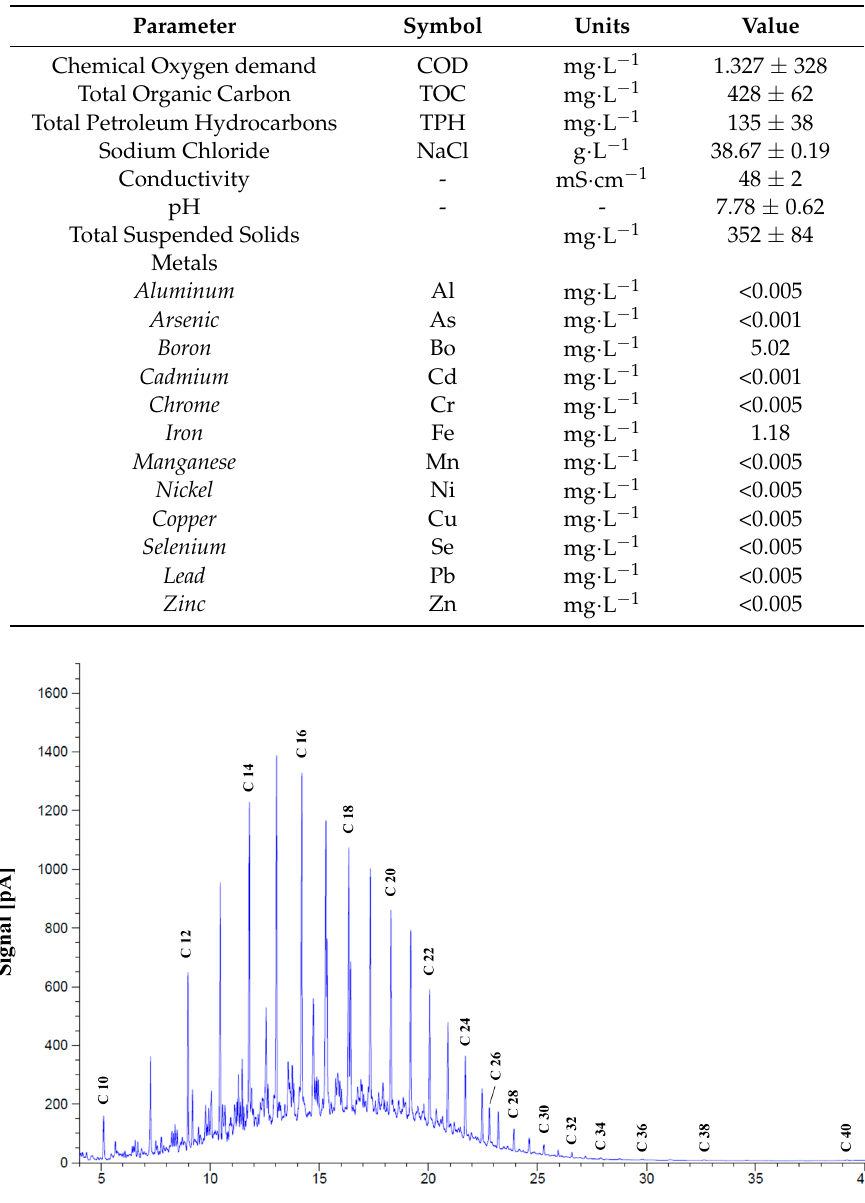
Table 1. Main characteristics of the industrial slop wastewater after de-oiling.